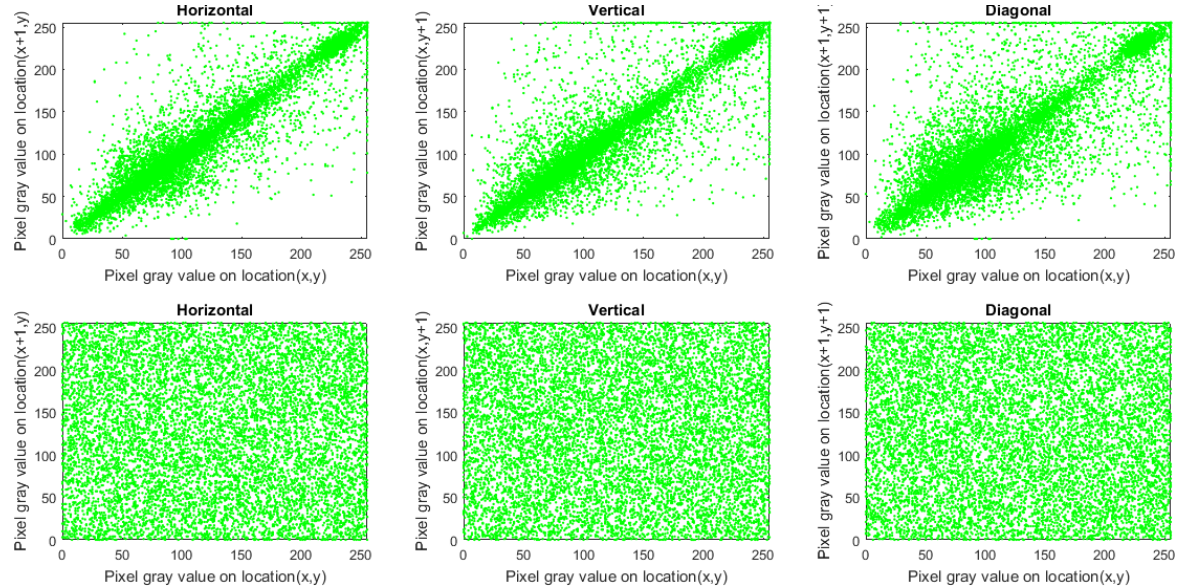
Figure 5. Correlation distribution of plain and ciphered Houses image for the green channel.